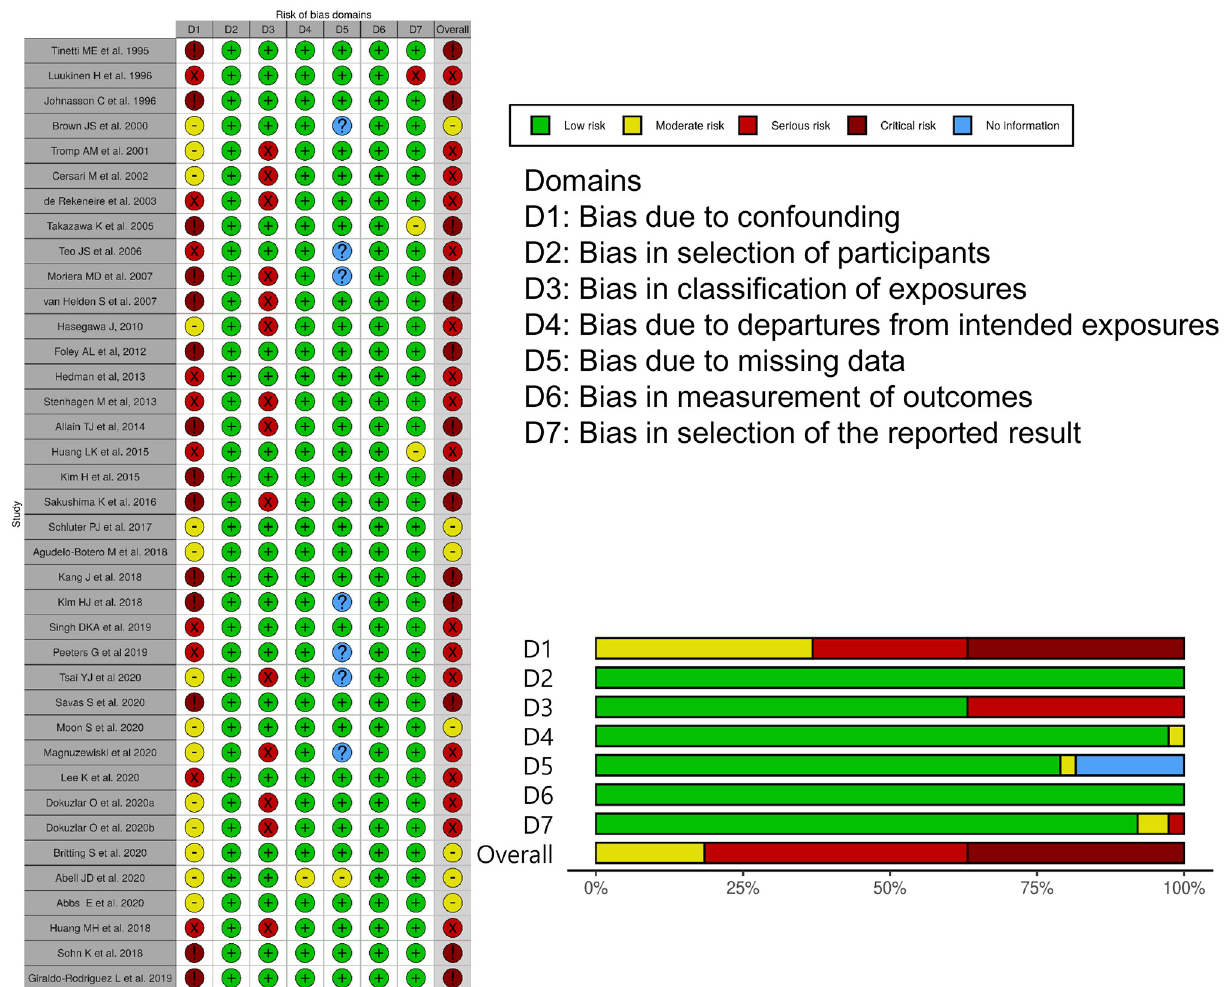
Fig 2. Quality assessment of the risk of bias in the 33 studies included in this